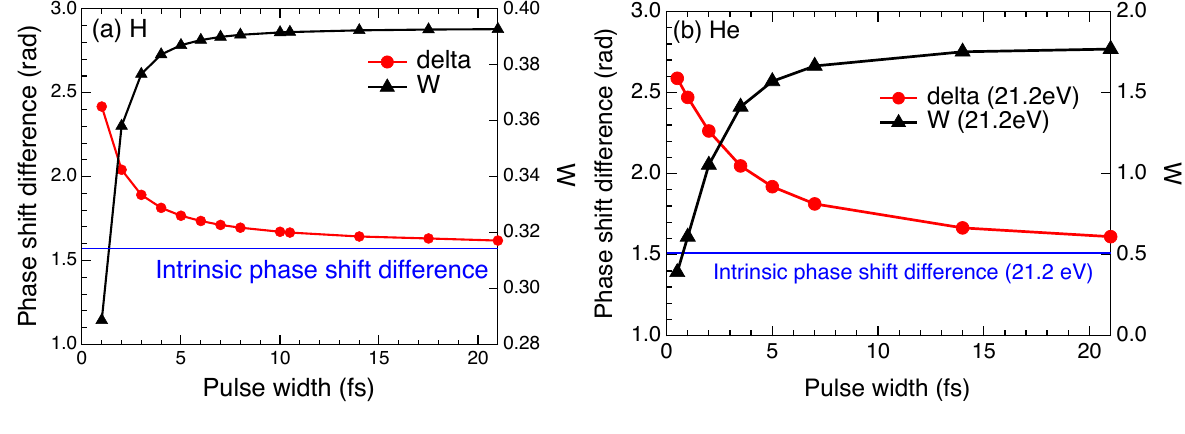
Figure 2. Pulse-width dependence of the TDSE-derived apparent phase shift difference (relative phase) δ (left axis) and W = | c and (cid:126) ω = 10 . 2 eV . The thin horizontal line denotes the value ( = π/ 2 )) of the Coulomb phase-shift difference; ( b ) The target atom is helium, and (cid:126) ω = 21 . 2 eV . The thin horizontal line denotes the value (1.511 [63]) of the intrinsic scattering phase-shift difference δ (cid:126) ω = 21 . 2 eV .